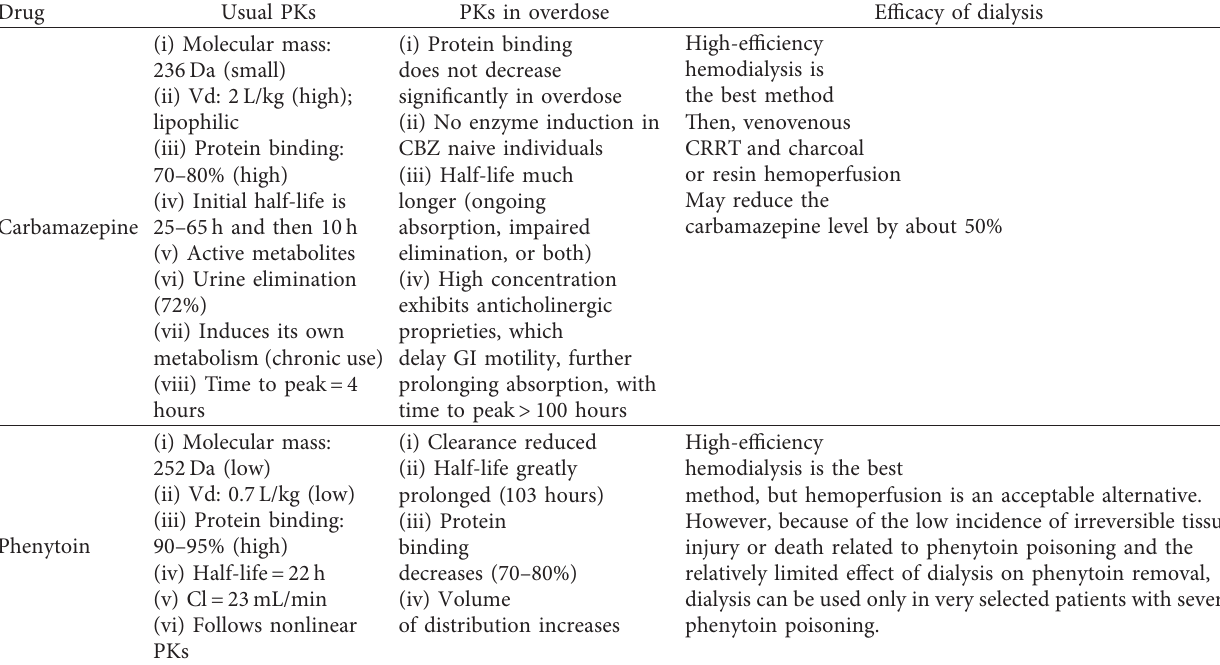
Table 2: Carbamazepine and phenytoin PKs and the likeliness of dialysis efficacy. Drug Usual PKs